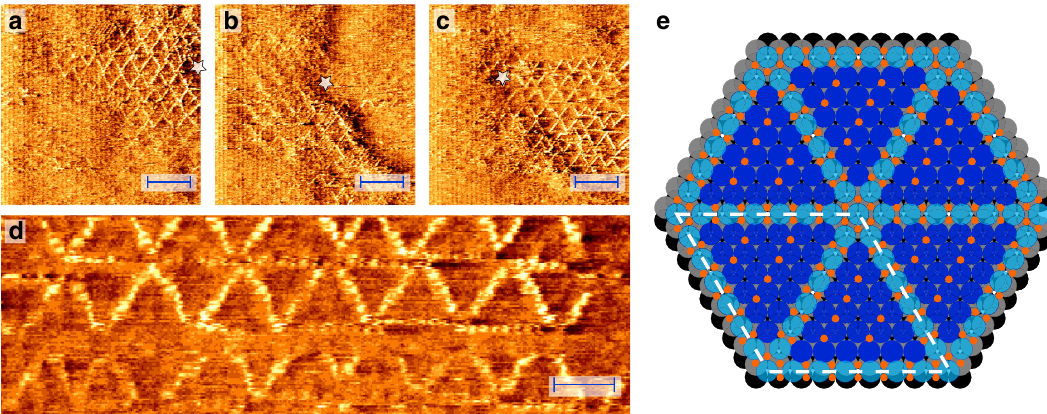
Fig. 1 Surface oxide on Pt(111). Surface oxide with spoked-wheel structure formed on Pt(111) while exposing it to 1 bar O 2 at 529 K. Three consecutive ( a – c ), large-scale STM images displaying extended domains. Field of view was slowly changing due to thermal drift (see white star as reference point); Enlarged detail ( d ), illustrating the atomic resolution within the spokes. Scale bars represent 4 nm ( a – c ) and 2 nm ( d ). Proposed ball model ( e ) showing the spoked wheels within, but lifted from, the surface layer (oxidized Pt, light blue ; O, orange ; Pt surface layers, blue , gray , and black ). Positions of O atom were based on previous experiments and theory 5,